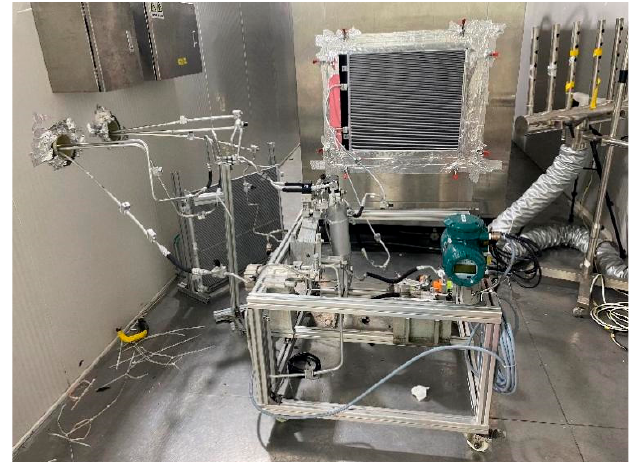
Figure 2. Outdoor chamber.